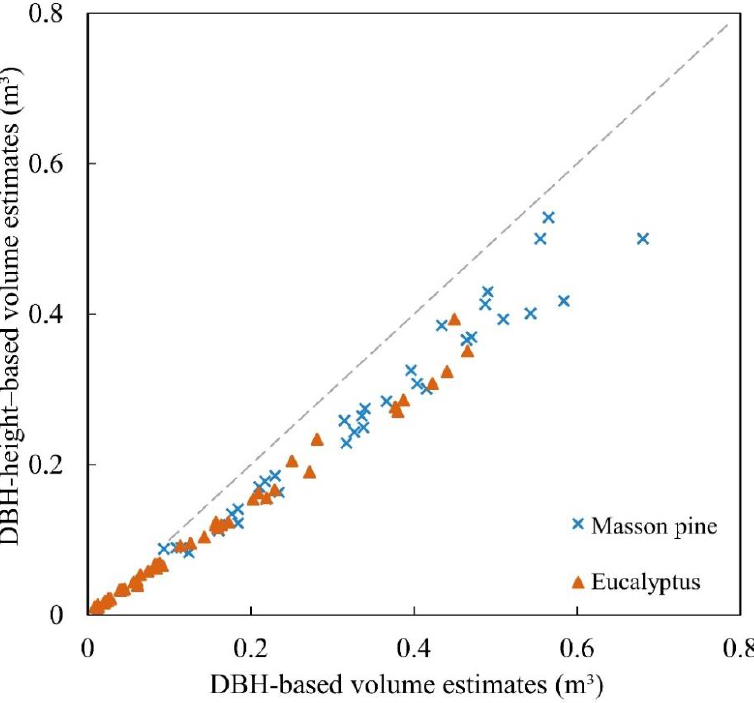
Figure 3. Comparative analysis of single-tree volumes from different allometric equations.